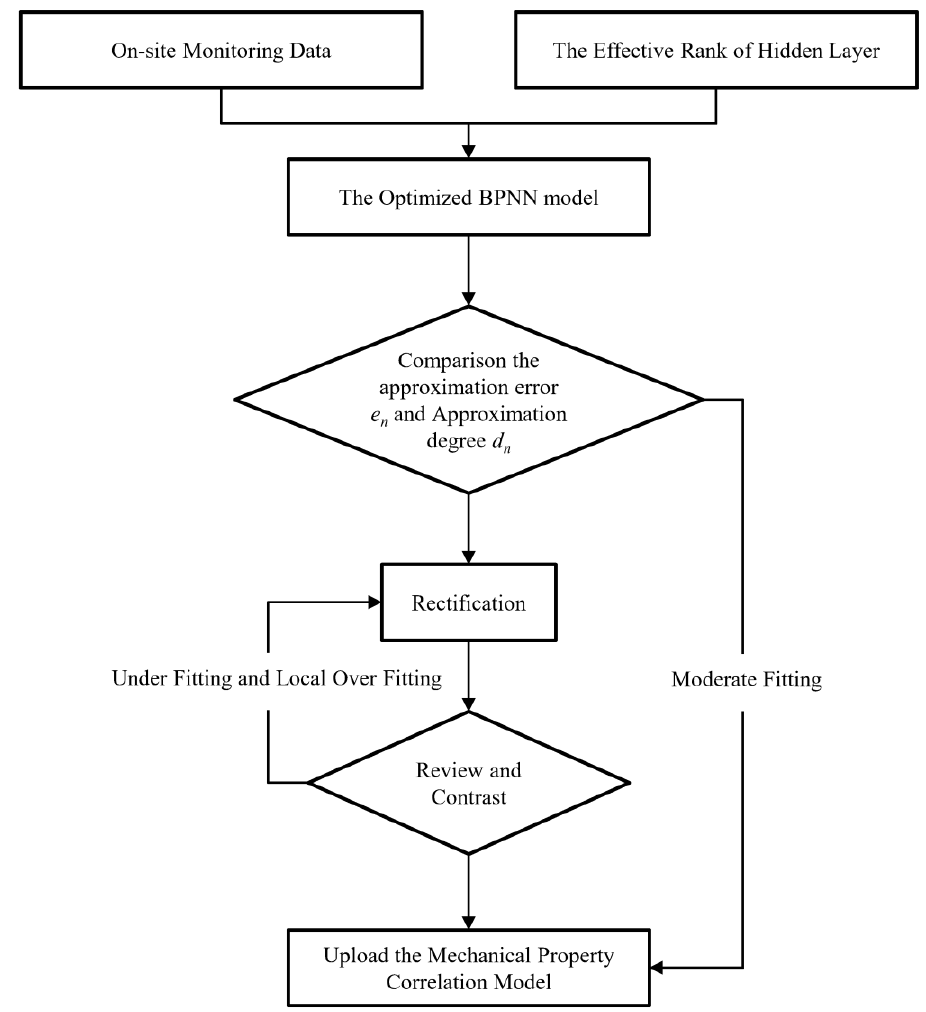
Figure 4. The research methodology and process.